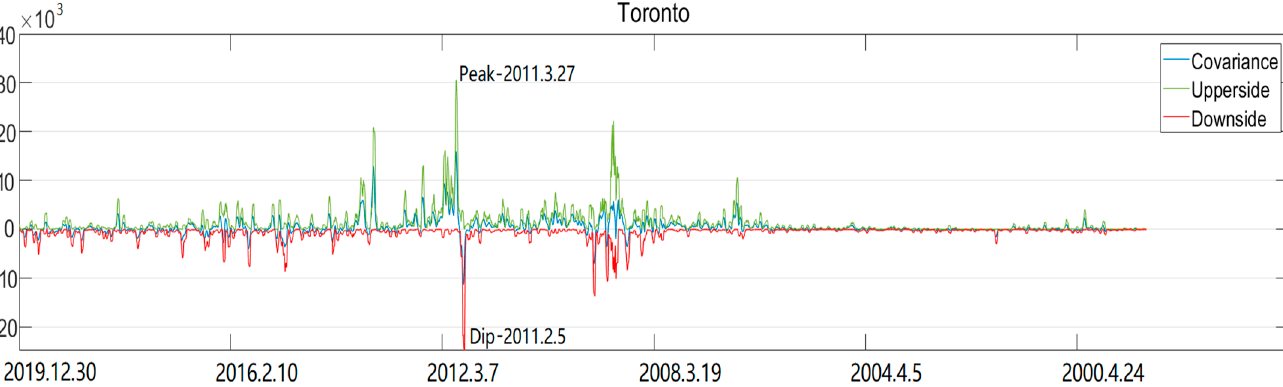
Figure 5. Bi ‐ weekly/semi ‐ covariances between gold price and Toronto Index Canada from the year 2019 back to 1999.